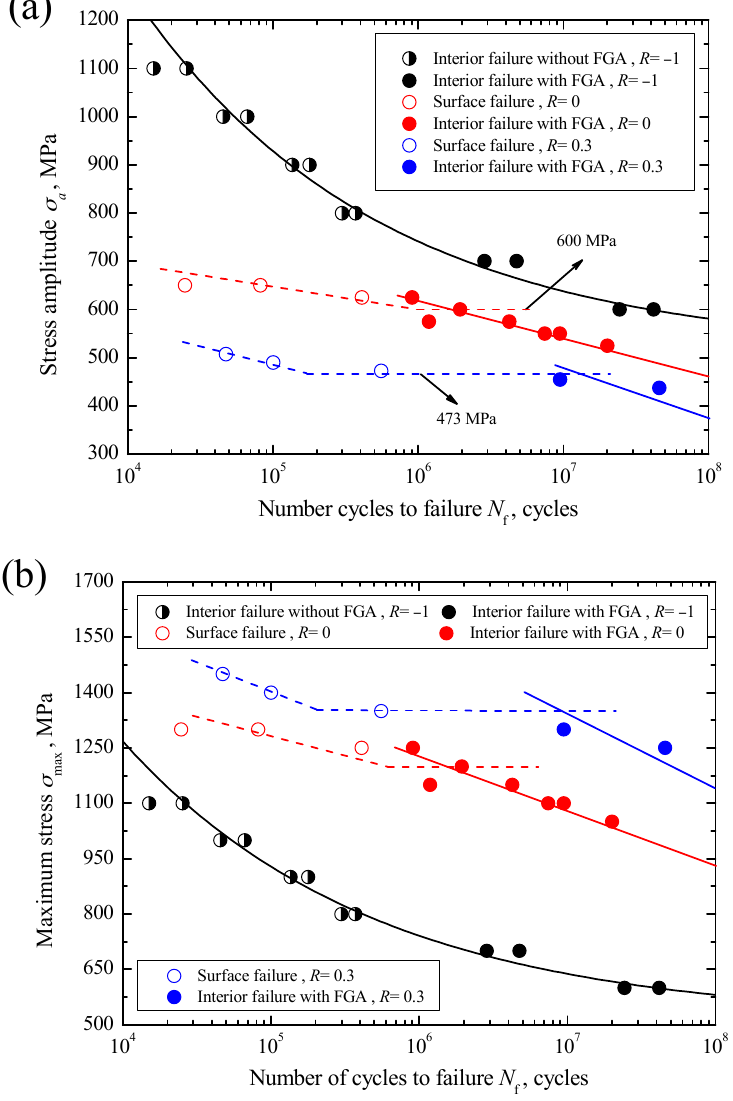
Figure 4. S-N curves of carburized Cr-Ni steel under stress ratios of − 1, 0 and 0.3: ( a ) σ a versus N f ; ( b ) σ max versus N f . ( b ) σ max versus N f